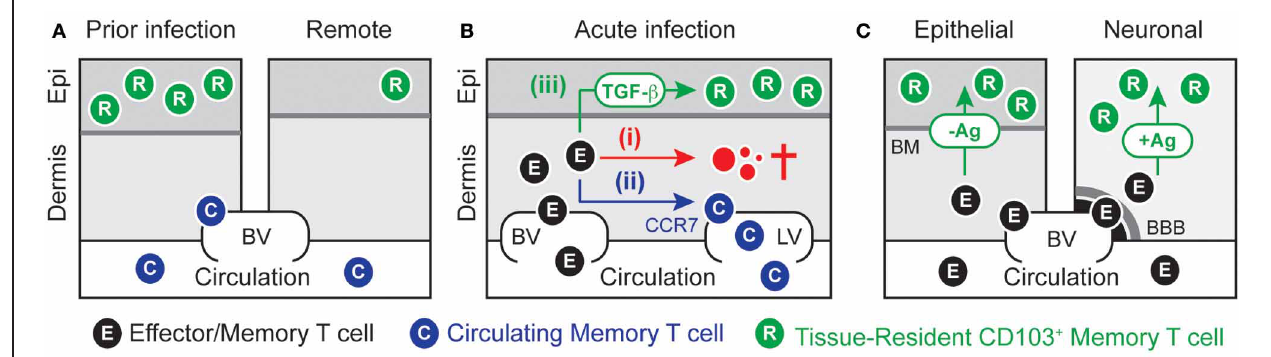
FIGURE 1 | Local differentiation and persistence of T RM cells. (A) Localized infection or inflammation of the skin generates a population of epidermal CD103 + T RM cells that exist in disequilibrium with their counterparts in the circulation. High numbers of T RM cells are concentrated at sites of previous infection or inflammation, whereas remote areas of skin contain only low numbers of these cells. (B) Effector CD8 + T cells that have infiltrated infected skin can undergo three principal fates. While the majority of cells are likely to (i) die in situ , others may (ii) egress the skin in a